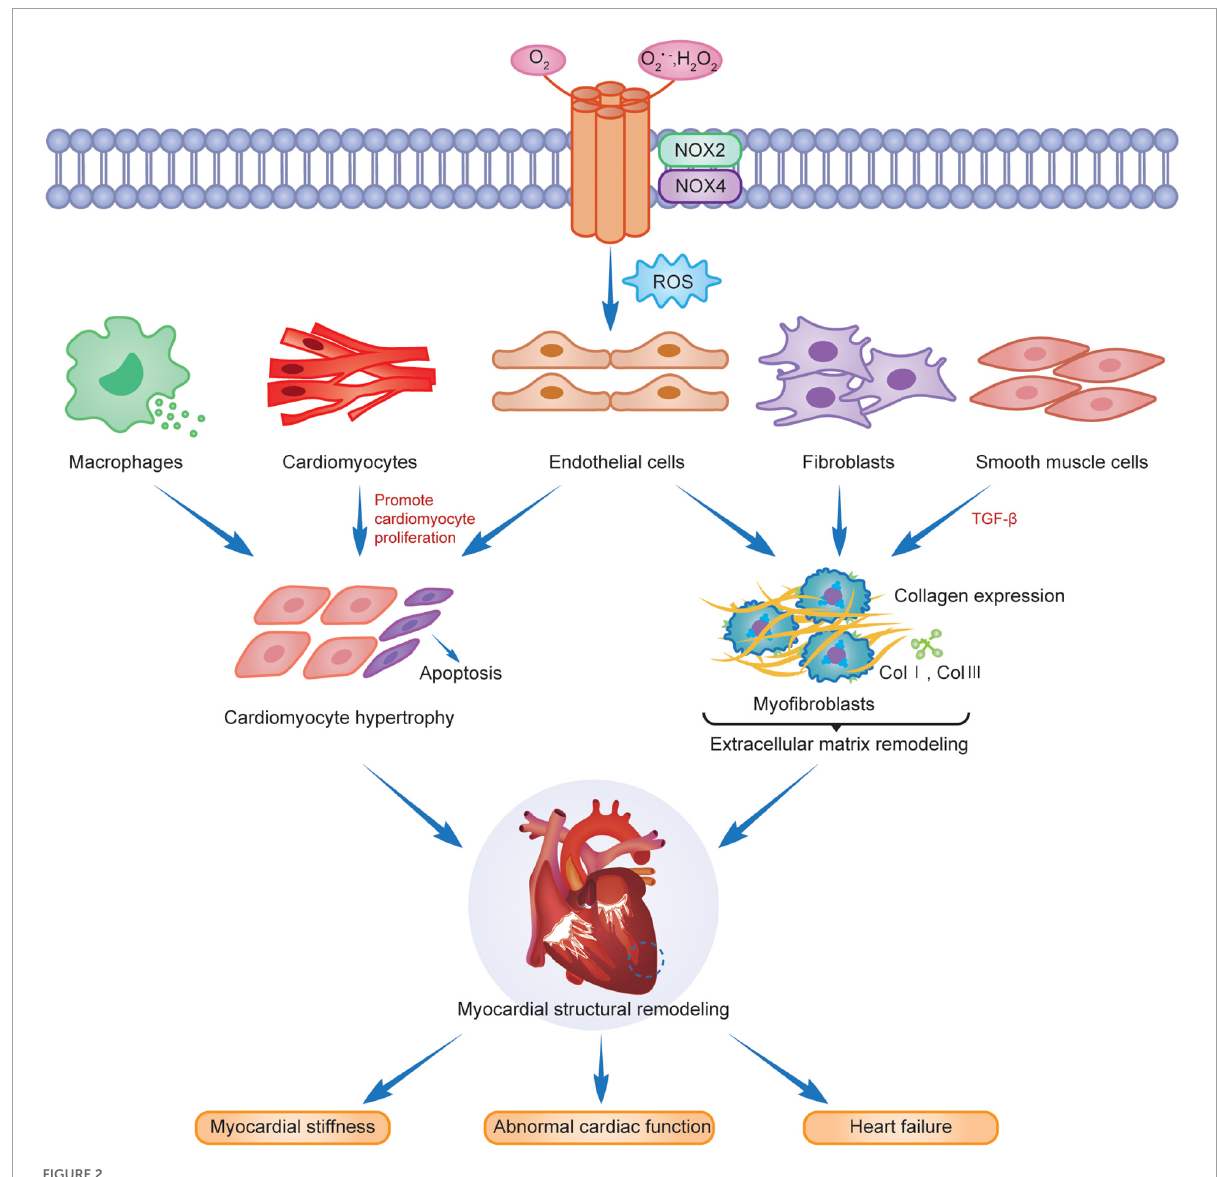
FIGURE2 NOX2 and NOX4 are involved in myocardial